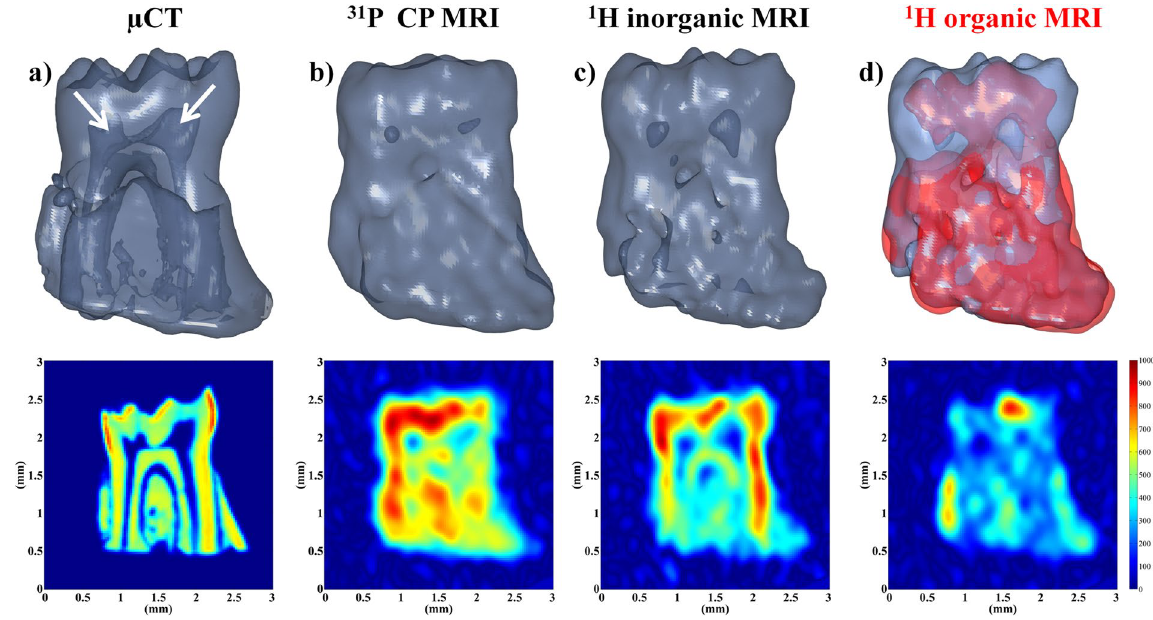
Figure 5. ( a ) 3D high-resolution µ CT image of the mouse tooth sample (isotropic spatial resolution reduced to 27 µ m). ( b ) 3D 31 P CPMAS MR image recorded at a spinning frequency of 10 kHz using a CP contact time of 3 ms. The data were recorded with a nominal spatial resolution of 250 µ m in the read dimension and 110 µ m in the phase dimension which decreased to 220 µ m after Hann apodization. 240 transients were co-added with a TR of 1 s corresponding to an experimental duration of 69 h. ( c , d ) 3D 1 H MAS MR chemically selective images of the ( c ) OH − hydroxyl groups and ( d ) aliphatic species in the mouse tooth sample. The nominal spatial resolution was 144 × 110 × 110 µ m 3 . 64 transients were co-added with a TR of 1 s corresponding to an experimental duration of 18.2 h. The dataset was zero-filled 2 times leading to an isotropic voxel size of 27 µ m. The 3D images are shown as isosurface representation and 2D cross-sections taken along the pulp channels of the tooth are shown below the 3D images. The white arrows indicate the location of the pulp channels.